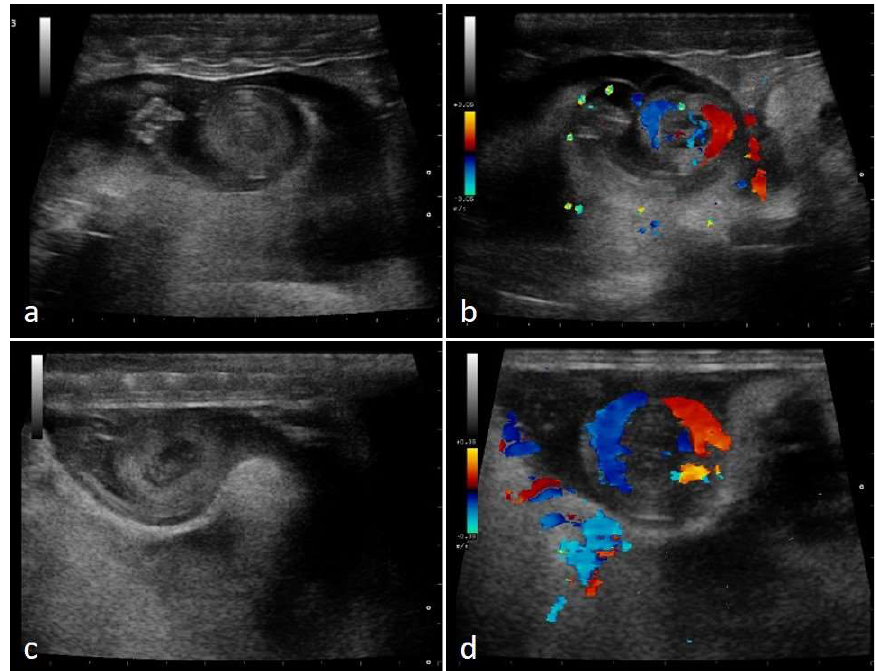
Figure 14. Gravid female boa 52 days after ovulation—flow towards the transducer is depicted in red, while flow away from the transducer is shown in blue. Embryo shows a snail-like appearance ( a ). By using color Doppler, it is possible to visualize vascularization ( b ). Gravid female boa 60 days after ovulation, embryos’ snail-like appearance is observed ( c ). Blood flows are highlighted through Doppler ( d ). Phases recognized in 100% of females who completed gestation.